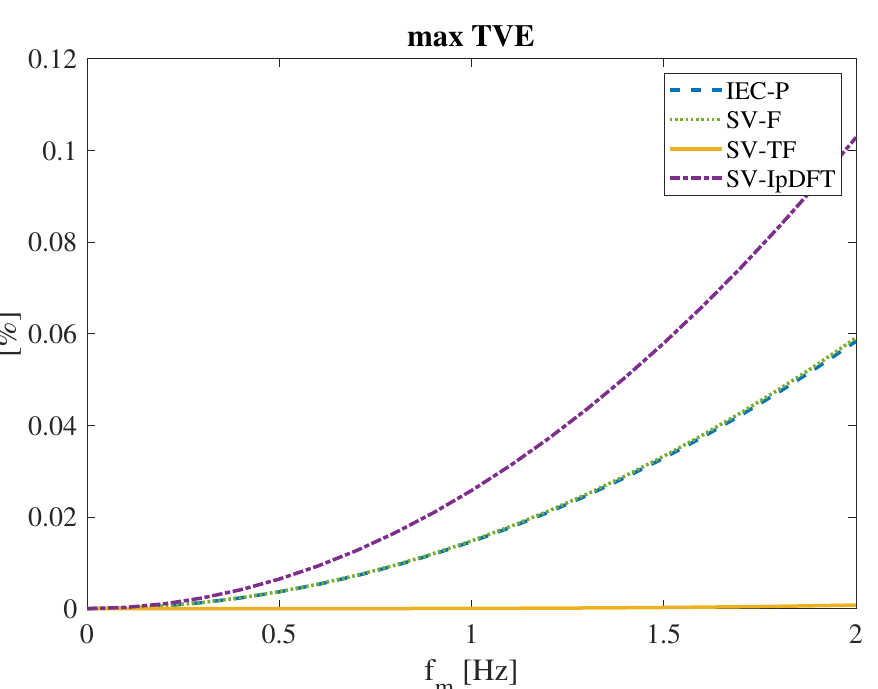
Figure 16. Maximum TVE results under amplitude modulations with modulation frequency f m . Frequency errors are either small or negligible (<2 · 10 − 3 mHz) for all algorithms but SV-IpDFT, which shows higher |FE| up to 13.25 mHz due to its underlying steady-state assumption that is not able to effectively cope with amplitude modulated input